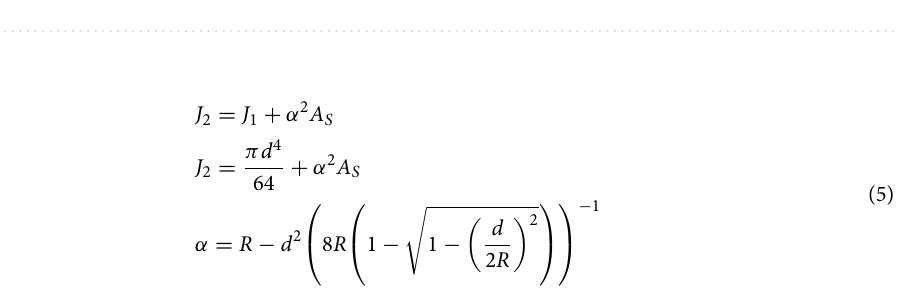
Figure 3. Force diagram of a round link in the chain, ( a ) geometry of the round link and ( b ) simplified force